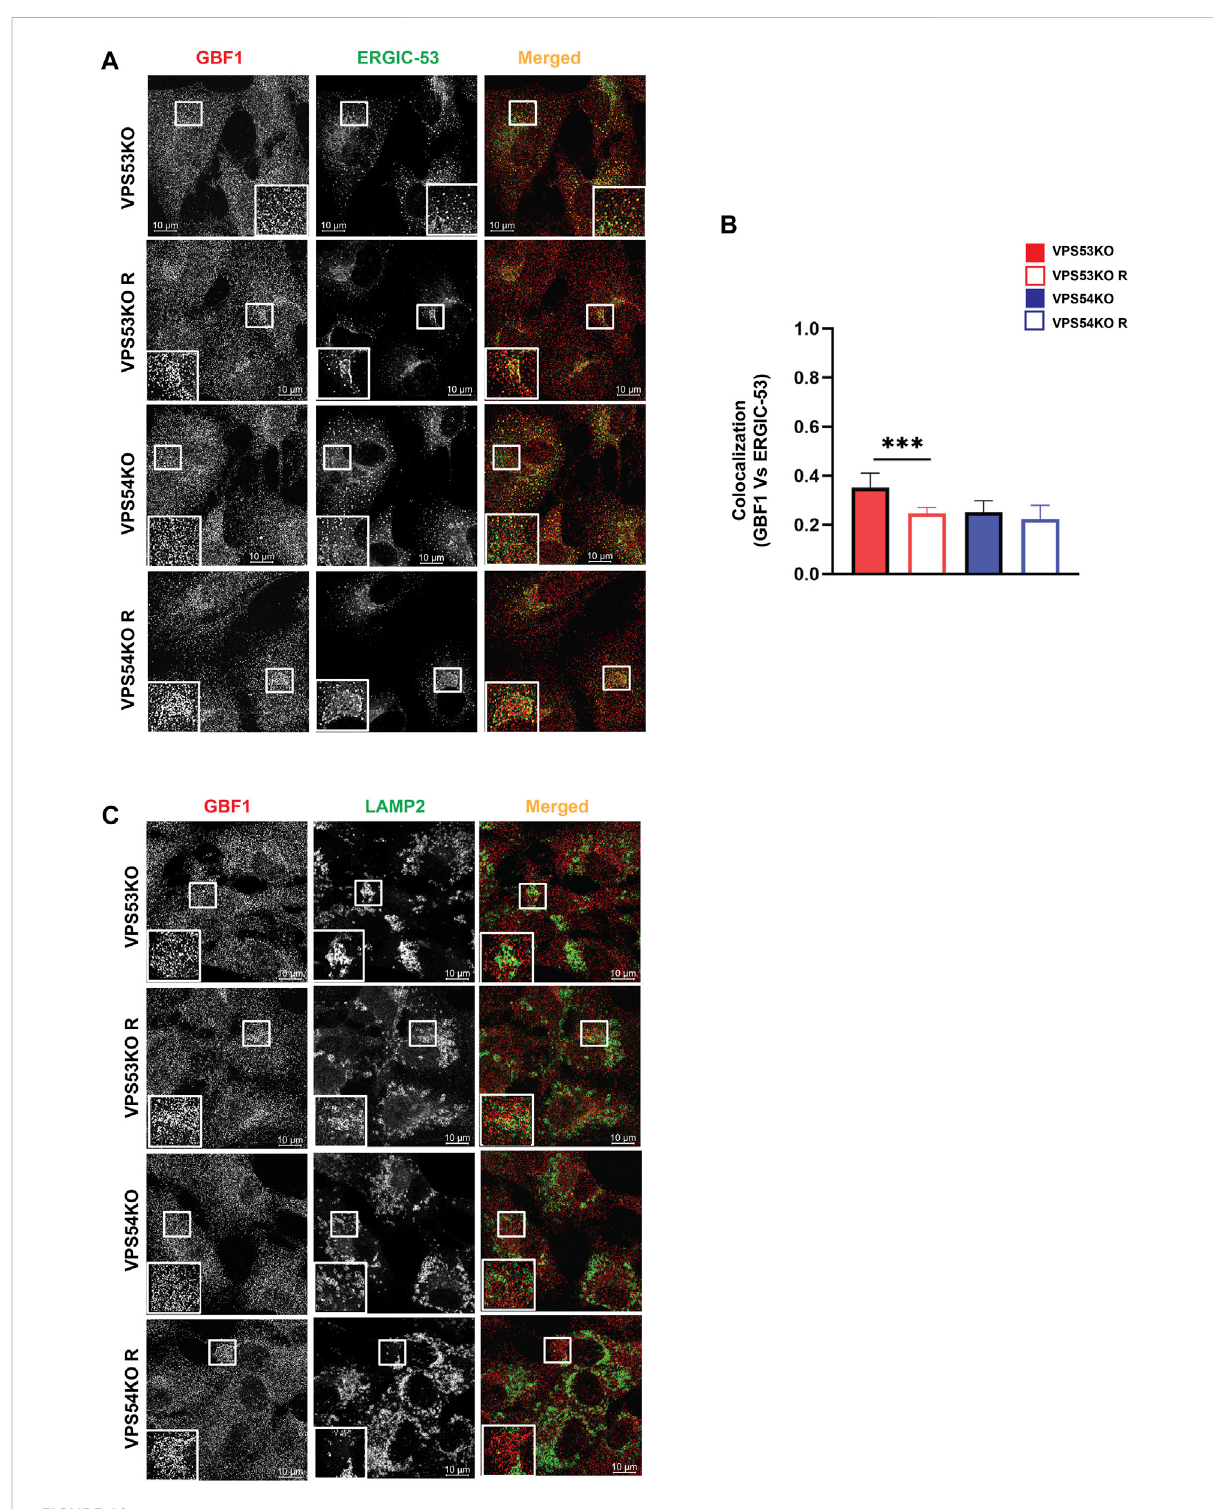
FIGURE 10 GBF1 is partially relocalized to ERGIC in GARP-KO cells. (A) Airyscan microscopy of VPS53KO, VPS54KO and their rescued cells for GBF1 and ERGIC-53. (B) ColocalizationanalysisofGBF1andERGIC-53usingPearson ’ scorrelationcoef fi cient. (C) AiryscanmicroscopyofVPS53KO,VPS54KO and their rescued cells for GBF1 and